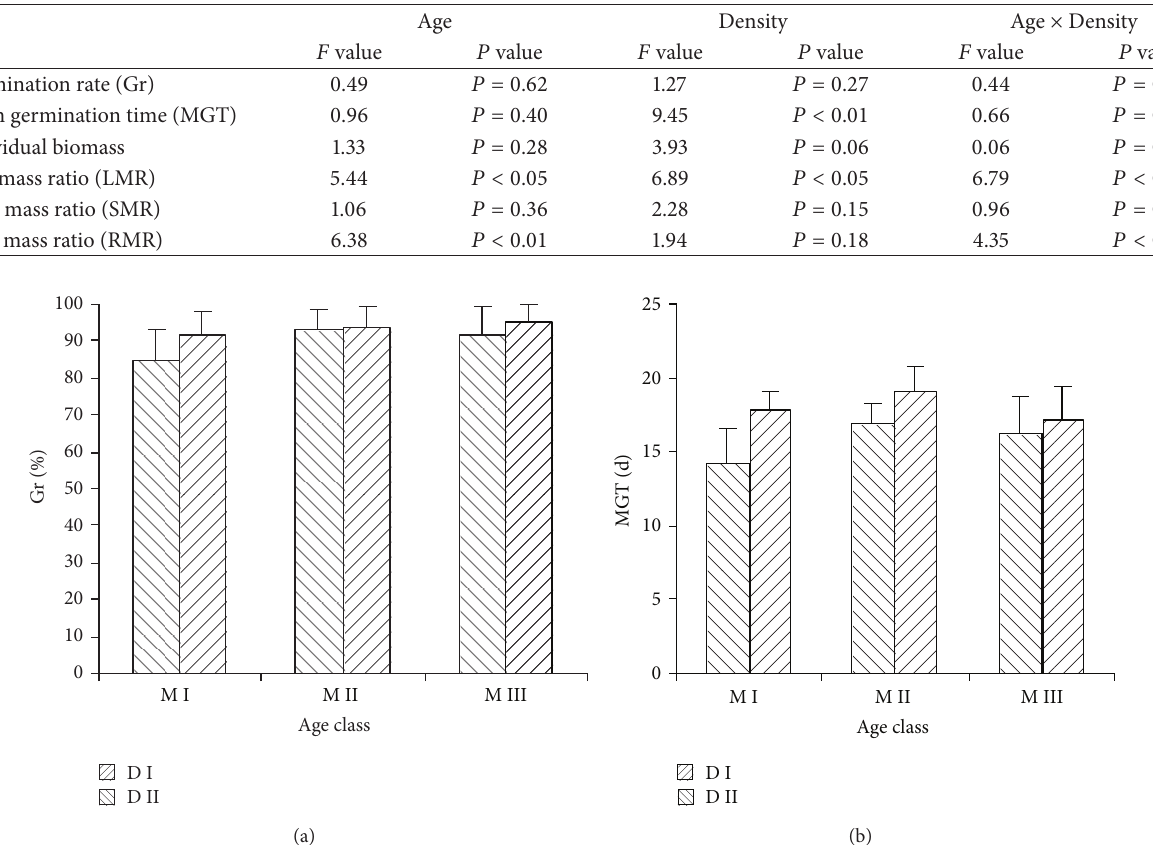
Table 2: Two-way ANOVA analyses of effects of age and stand density of mother tree age and their interaction on seed germination and seedling biomass allocation for Pinus thunbergii.